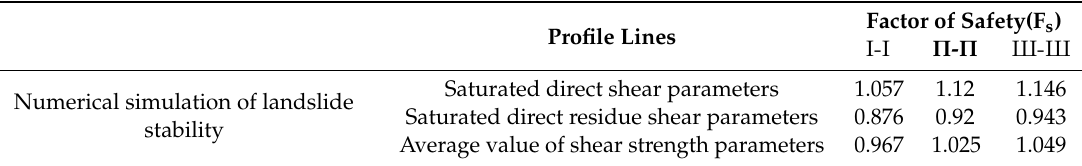
Table 5. Numerical simulation results of the safety coefficient.